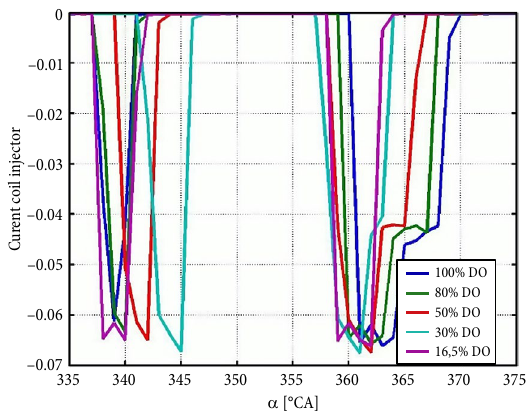
Fig. 8. Injector control current versus CA, n = 1500 rpm; T = 100 Nm (different doses of diesel oil)